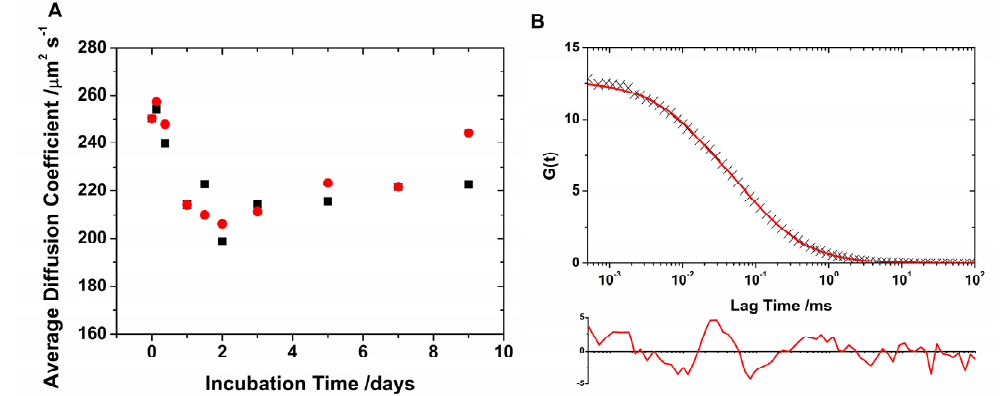
Figure 2. ( A ) Average diffusion coefficient as a function of incubation time for AF488- (black) and AF647-labeled (red) N47A Spc-SH3. ( B ) Example of lifetime-weighted autocorrelation curve (AF488 channel, 48 h of incubation time) fitted using a single diffusive species (Equation 2). The residuals plot (below) indicates a poor